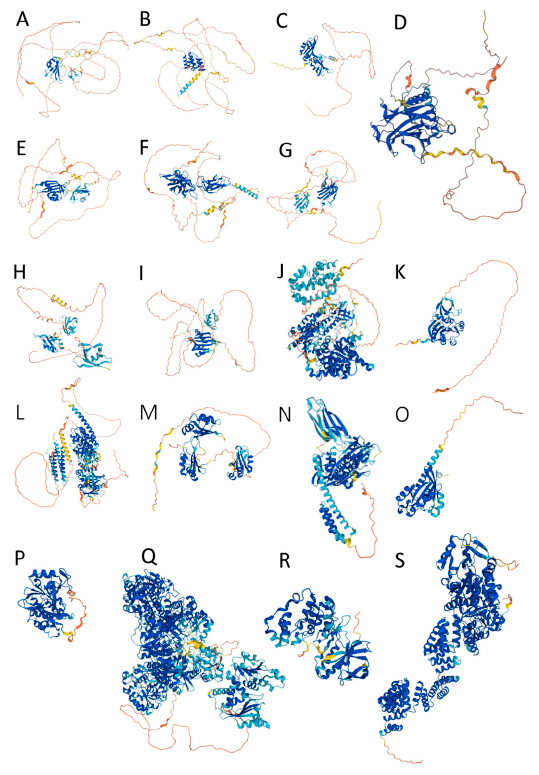
Figure 2. Three-dimensional structures modeled for query proteins by AlphaFold2 as retrieved from UniProt. ( A ). FUS (UniProt ID: P35637); ( B ). MAVS (UniProt ID: Q7Z434); ( C ). hnRNPA2 (UniProt